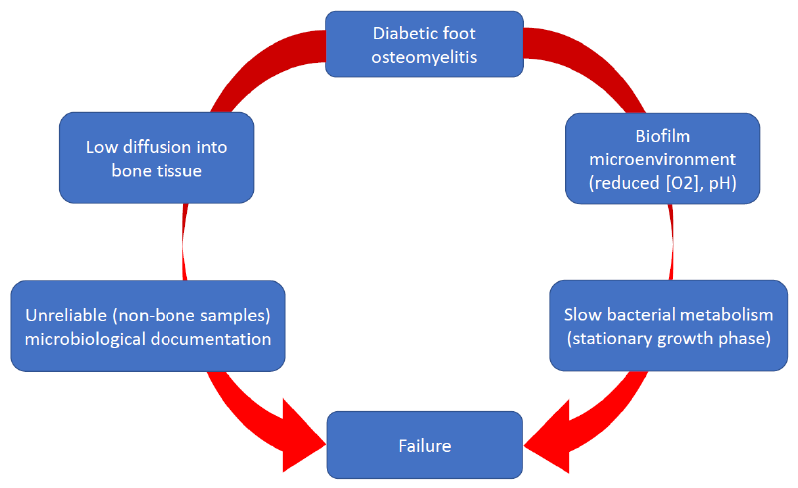
Figure 1. Limitations for the antibiotic therapy of diabetic foot osteomyelitis. Table 1. Activity of different antibiotics against biofilm-related infection (modified from Ref.